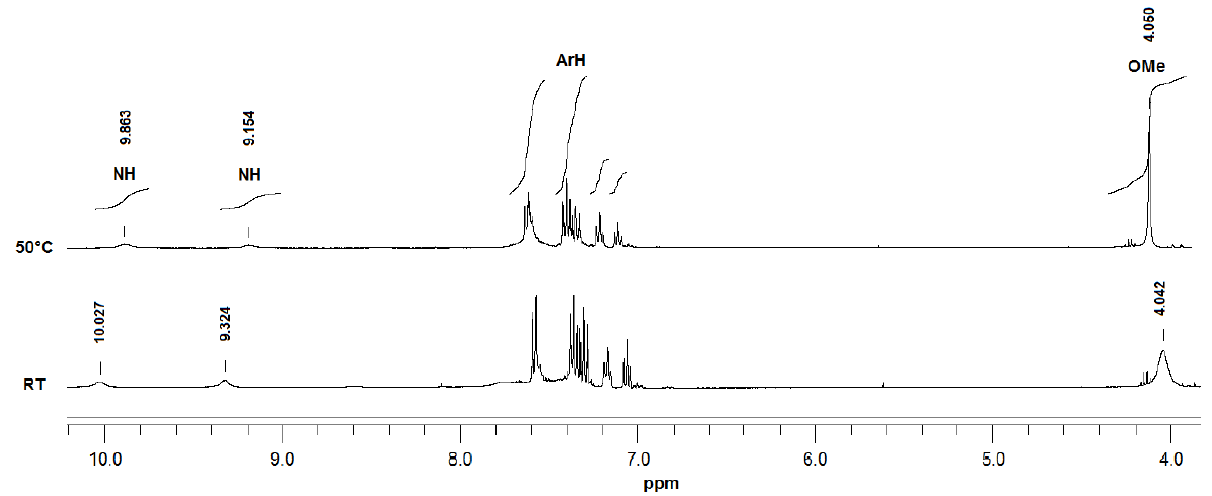
◦ C. Figure 1. 1 H NMR spectra (400 MHz, acetone-d 6 ) of compound 1 at RT and 50 °C. Figure 1. 1 H NMR spectra (400 MHz, acetone- d 6 ) of compound 1 at RT and 50 Since according to a literature survey, no Bi(III) complexes ligated by thiocarbamates have been crystallographically characterized yet, we examined the product crystallizing in Figure 1. 1 H NMR spectra (400 MHz, acetone-d 6 ) of compound 1 at RT and 50 °C. the triclinic space group P 1 by an X-ray diffraction study performed at 100 K. As shown in Figure 2, a dinuclear species has formed, in which the two crystallographically different coordinated Bi(III) centers are linked mutually through two µ 2 -bridging I3 and I4 iodido ligands. The Bi ··· Bi separation of 4.720 Å excludes any intermetallic interaction.